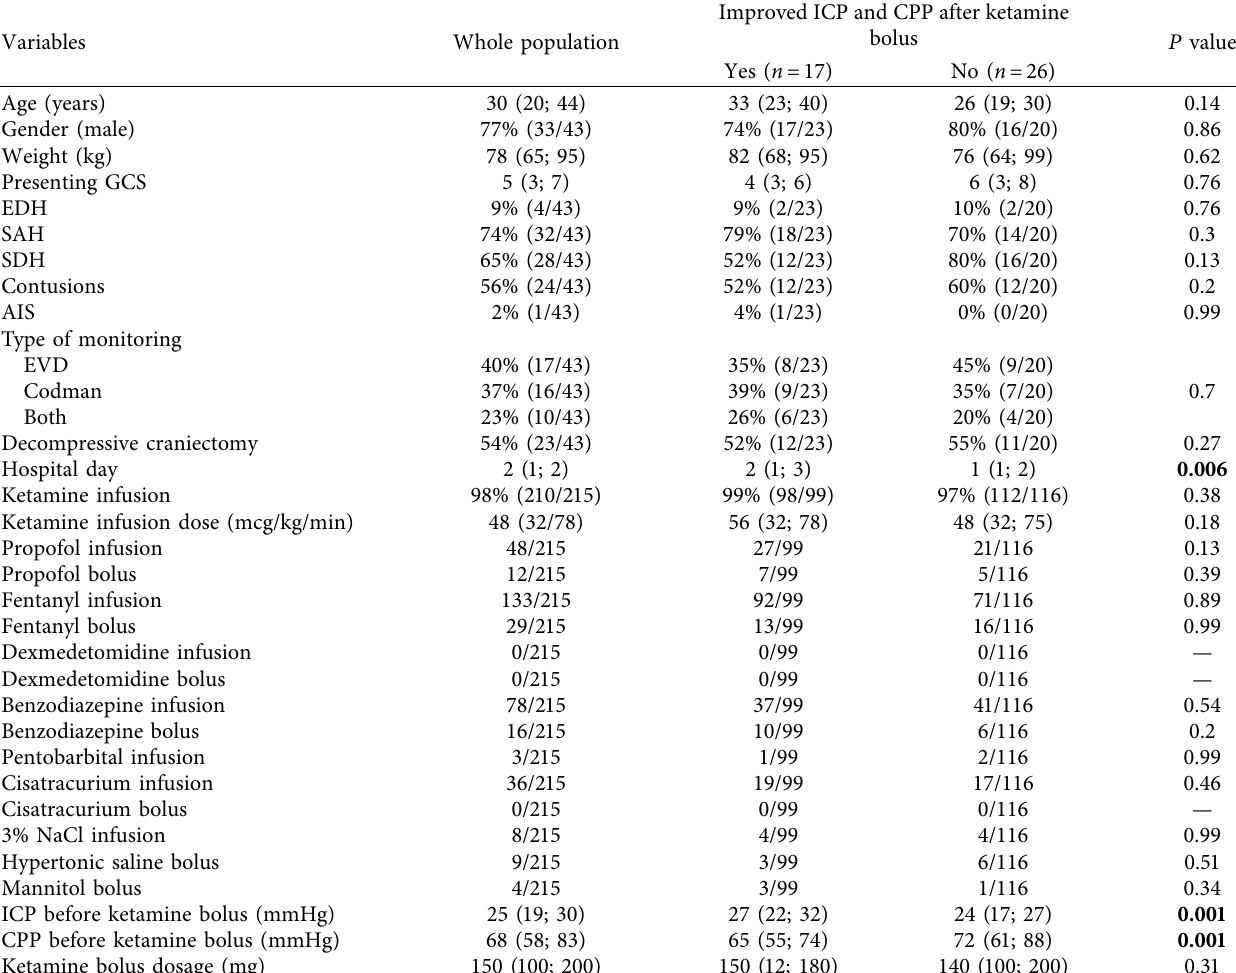
Table 1: Demographics, cointerventions, and outcomes according to the effect on intracranial pressure and cerebral perfusion pressure.